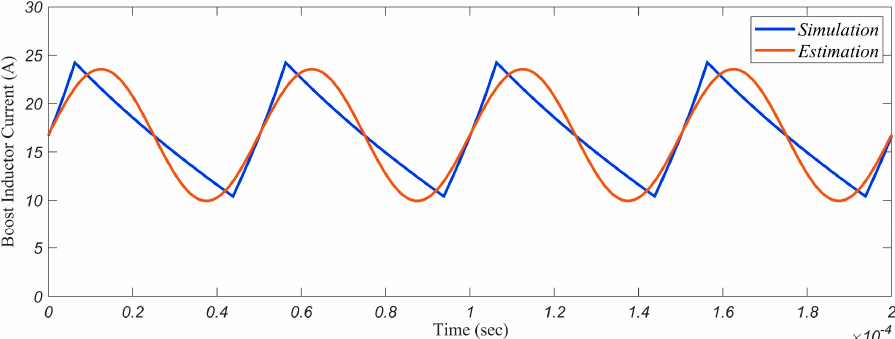
Figure 10. Modeled boost converter current waveform and simulation validation.